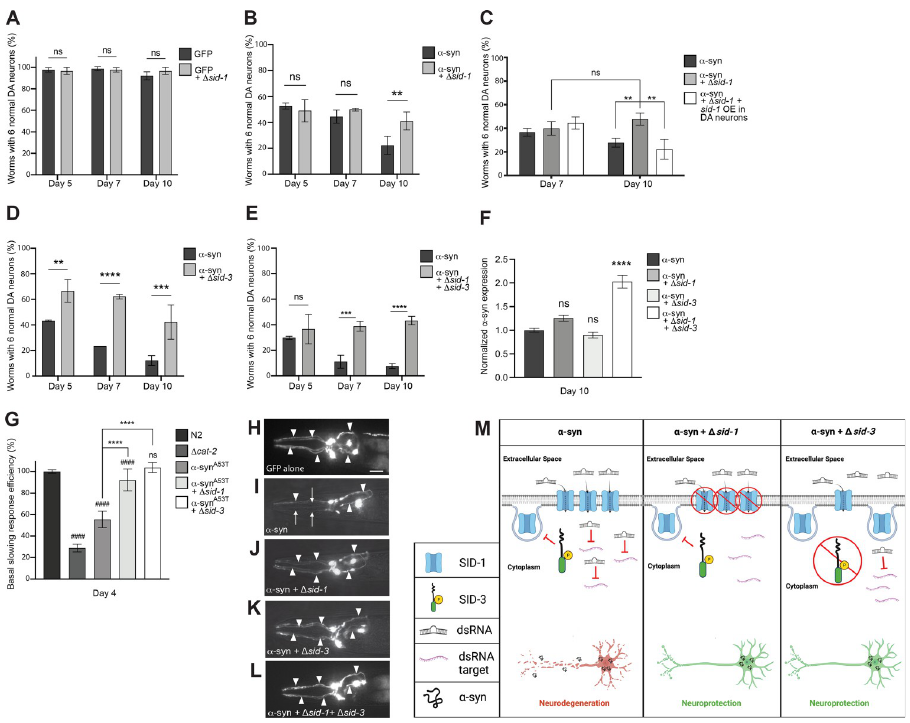
Fig 1. Loss of SID-1 and/or SID-3 functionality decreases DA neurodegeneration and improves DA neuron function. ( A-E ) DA neurons were scored for degeneration on days post-hatching indicated on X axes. Values represent mean + S.D. (n = 30 worms per genotype per replicate, 3 independent replicates per experiment). Two-Way ANOVAs with Sˇı´da´k’s post hoc analyses were used for comparisons of transgenic animals at each time point ( A, B, D, E ) while a Tukey’s post hoc analysis was used to compare all conditions to each other in panel C ; ns P � 0.05, �� P < 0.01, ��� P < 0.001, ���� P < 0.0001. ( F ) Expression levels of α -syn in α -syn only worms and α -syn worms with sid mutations. Expression is normalized to the α -syn only group. Total RNA was isolated at day 10 post-hatching. One- Way ANOVA with Dunnett’s post hoc analysis was used to compare α -syn alone to α -syn + sid-1(pk3321) , α -syn + sid- 3(ok973) , and α -syn + sid-1(pk3321) + sid-3(ok973) ; ns P � 0.05, ���� P < 0.0001. ( G ) Basal Slowing Response Efficiency assay, normalized to N2. cat-2 mutants synthesize significantly less DA than N2 worms and serve as a positive control. Transgenic worms expressing a familial mutant of α -syn, without GFP in the neurons, P :: α - dat-1 syn A53T , along with sid-1(pk3321) and sid-3(ok973) mutant backgrounds, were used in this assay to quantify early changes in neurotransmission. Worms were tested on day 4 post-hatching. One-Way ANOVA with Tukey’s post hoc analysis was used to compare all conditions to each other. Symbols above bars are in comparison to N2 control; ns P � 0.05, #### P < 0.0001. Symbols above brackets are in comparison to bars indicated. ���� P < 0.0001. ( H-L ) These images represent the six anterior DA neurons in characteristic worms expressing GFP in the six head neurons on day 10 post-hatching. Arrowheads indicate intact DA neurons while arrows indicate degenerated DA neurons. Scale bar, 20 μ m. ( H ) This animal expresses GFP only and displays a full complement of 6 anterior DA neurons. ( I ) GFP + α -syn expressed in DA neurons where the arrowheads indicate only 3 neurons are intact while 3 neurons are degenerating (arrows). ( J ) GFP + α -syn expressed in DA neurons in a sid-1(pk3321) mutant background; all 6 anterior DA neurons are intact. ( K ) GFP + α -syn expressed in DA neurons in a sid-3(ok973) mutant background; all 6 anterior DA neurons are intact. ( L ) GFP + α -syn expressed in a sid-1(pk3321); sid-3(ok973) double mutant background; all 6 anterior DA neurons are intact. ( M ) A tripartite illustration (created with Biorender.com) depicting an interpretation of the results obtained where the activity of SID-1 and/or SID-3 modulates dsRNA import, leading to differential effects on α -syn- induced DA neurodegeneration. The left pane displays a scenario where α -syn is expressed in DA neurons, while sid-1 and sid-3 are both wildtype: activated SID-3 functions as an endocytic brake, thereby preventing endocytosis of SID-1, which maintains the transport of dsRNAs that silence target genes in DA neurons, rendering them vulnerable to neurodegeneration. The middle pane displays the situation when α -syn is expressed in DA neurons of animals in which sid-1 is mutant and sid-3 is wildtype: here, the loss of SID-1 function results in reduced dsRNA transport, thereby leading to the neuroprotection from α -syn overexpression observed, as a logical consequence of attenuated gene silencing and the concomitant transcriptional upregulation of protective gene products. In the right pane, sid-1 is wildtype and sid-3 is mutant in the same neurotoxic α -syn background: when SID-3 is incapacitated by mutation the endocytosis of SID-1 is no longer blocked, resulting in diminished dsRNA import and a reduction in the silencing of neuronal target gene expression that leads to the enhanced neuroprotection observed experimentally.